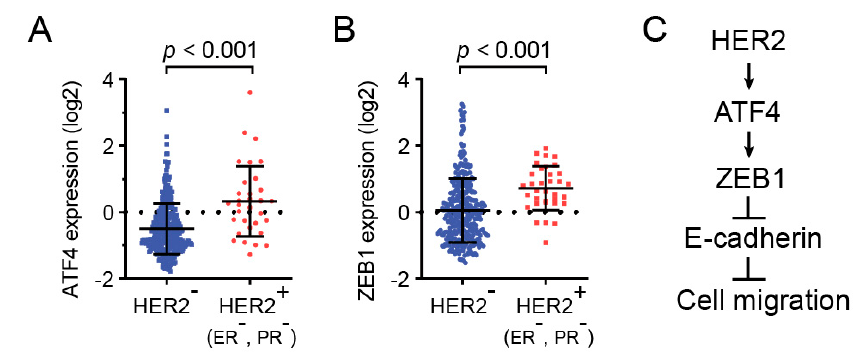
Figure 4. HER2, ZEB1, and ATF4 expression were analyzed in human breast cancers. mRNA levels of ATF4 or ZEB1 in HER2-positive or -negative breast cancer biopsy samples were analyzed using TCGA databases ( A , B ). A schematic model for the role of ATF4 in HER2-mediated cell migration ( C ).